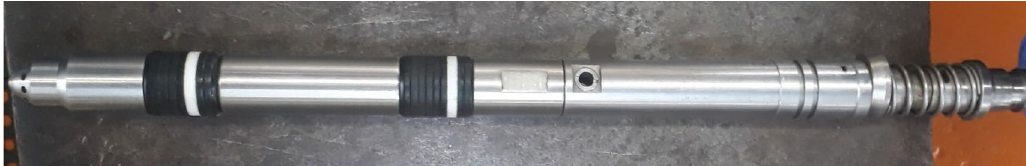
Fig. 1 The regulator valve for polymer injection